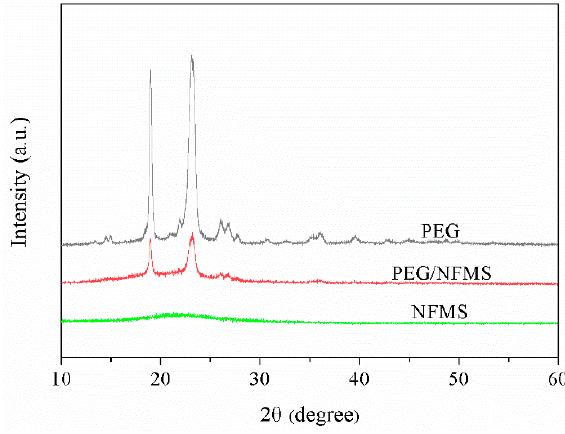
Figure 3. X-ray diffraction (XRD) patterns of PEG, NFMS, and PEG/NFMS.